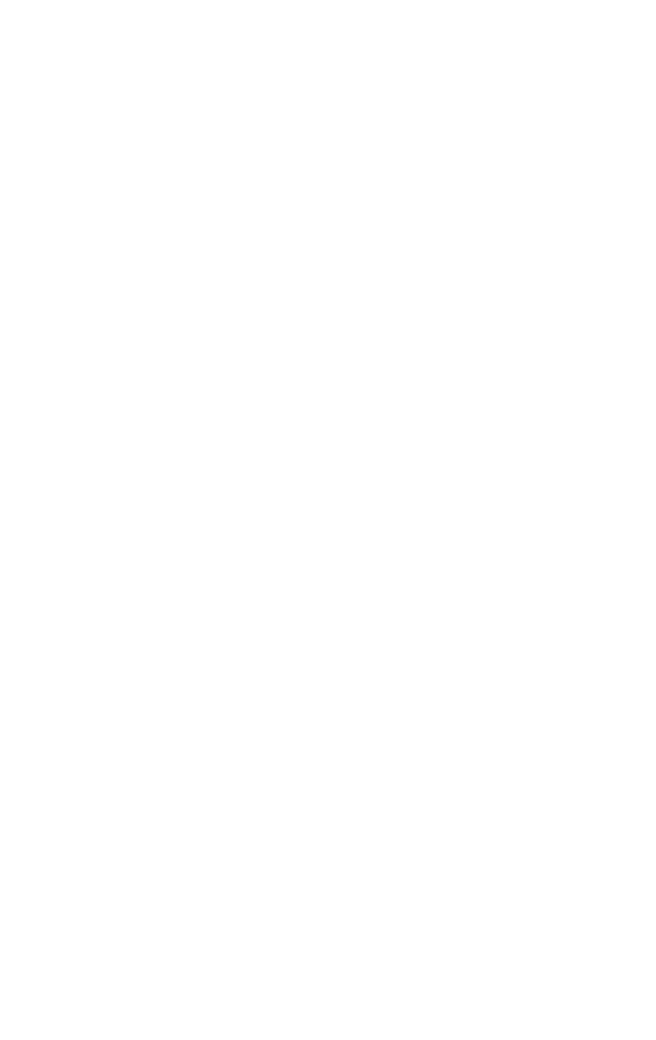
FIG. 3. (A) Time course of TNF cytotoxicity produced by AMC cultured in complete RPMI-1640 containing 0.02 m g/ml of LPS. Crude supernatants were harvested at the time indicated and TNF cytotoxicity in 10 ´ diluted cell-free supernatants was analyzed. (B) Time course of TNF cytotoxicity produced by AMC activated under 1h of 0.02 m g/ml LPS stimulation. Crude supernatants were harvested at the time indicated and TNF cytotoxicity in 4 ´ diluted cell-free supernatants was